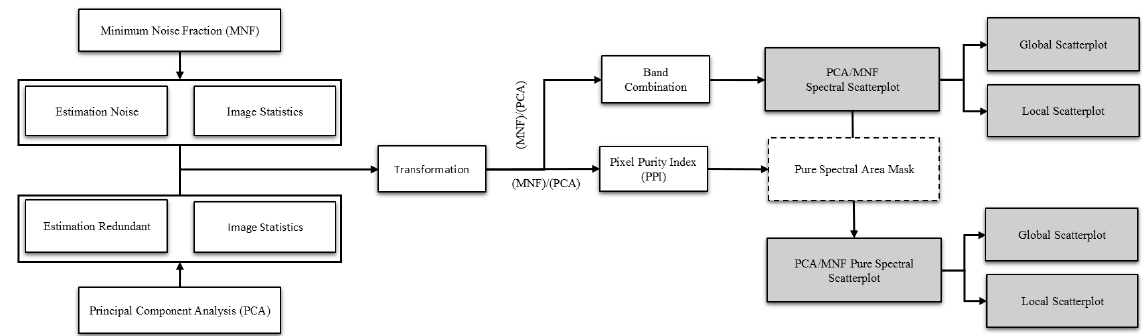
Figure 2. The process of candidate endmember selection of each endmember combination based on four strategy models: PCA/MNF Spectral + Global scatterplot, PCA/MNF spectral + Local Scatterplot, PCA/MNF pure spectral + Global scatterplot, and PCA/MNF pure spectral + Local